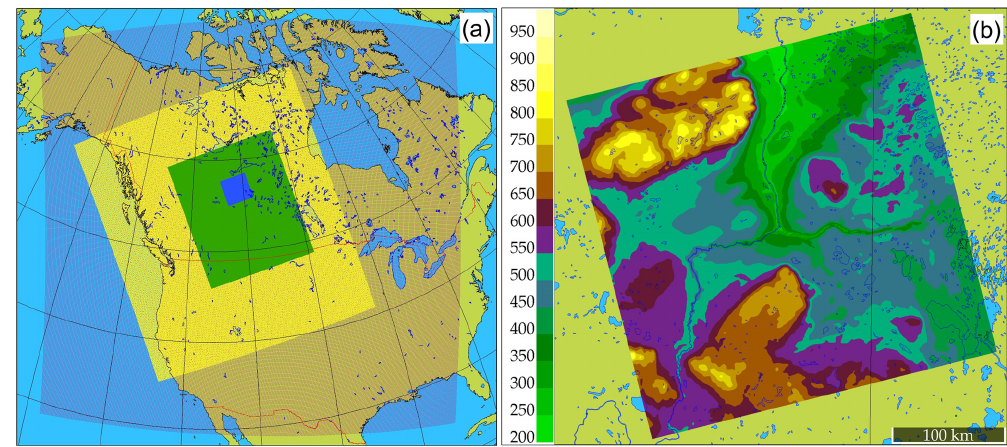
Figure 2. (a) The four nested domains of the GEM-MACH simulations. From outermost to innermost domains, these are CONT10km (outermost, red dots), OS10km (yellow), OS2.5km (green), and OS1km (blue). The model simulations from the two innermost domains are the focus of the present study. (b) Topography in the OS1km domain centered on Fort McMurray, Alberta (ma.g.l.). The coloured area corresponds to the central blue domain in (a) .